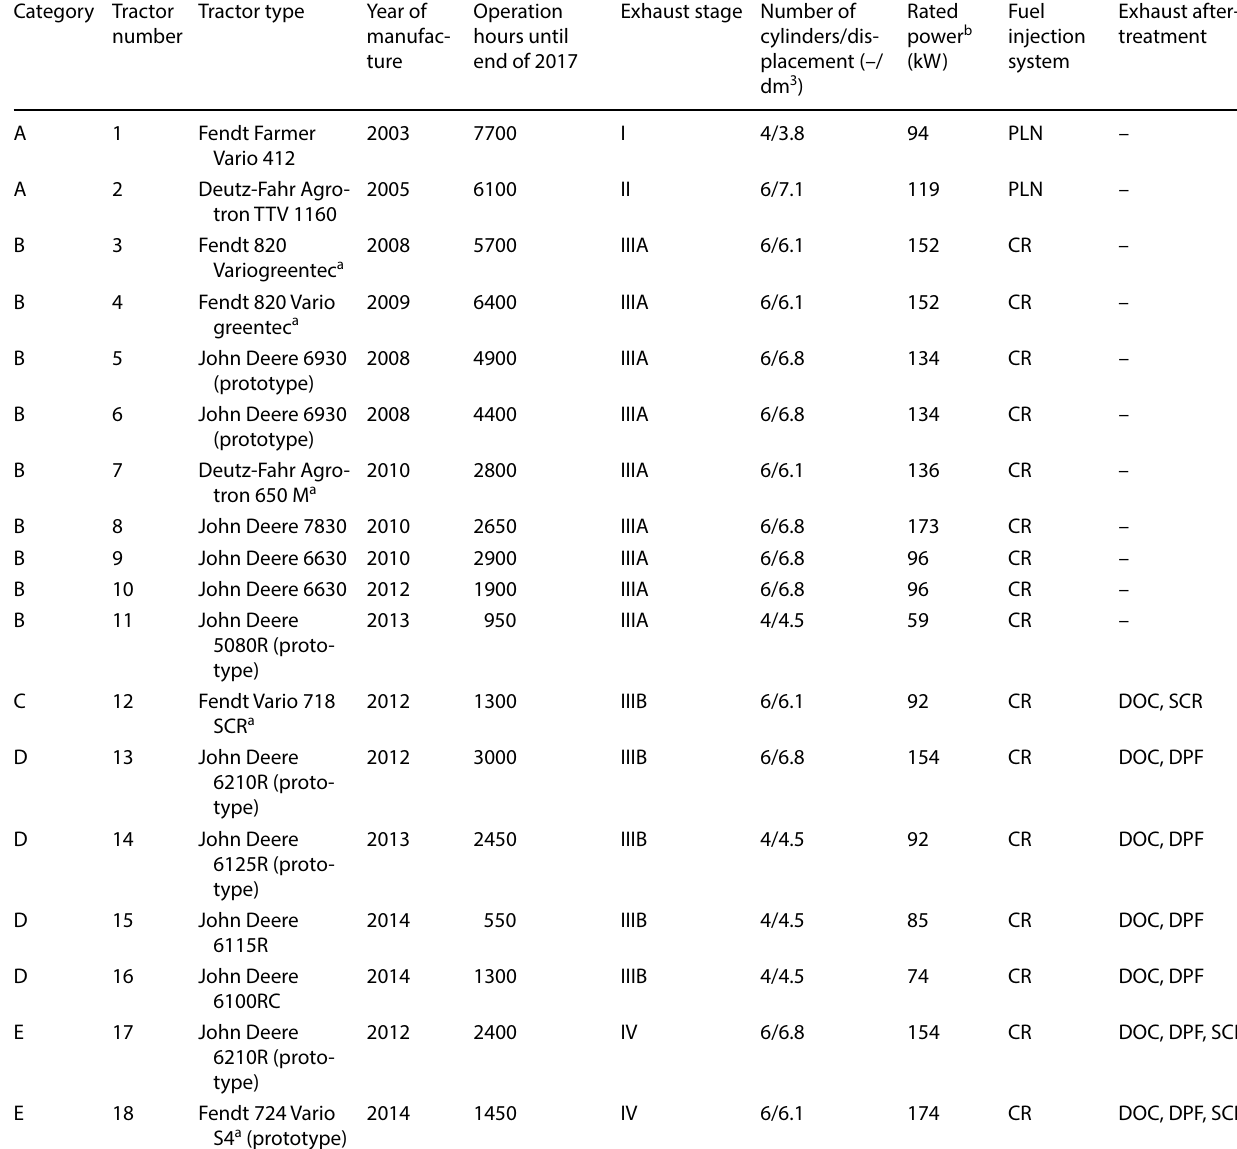
Table 1 Technical data of the monitored R100-compatible